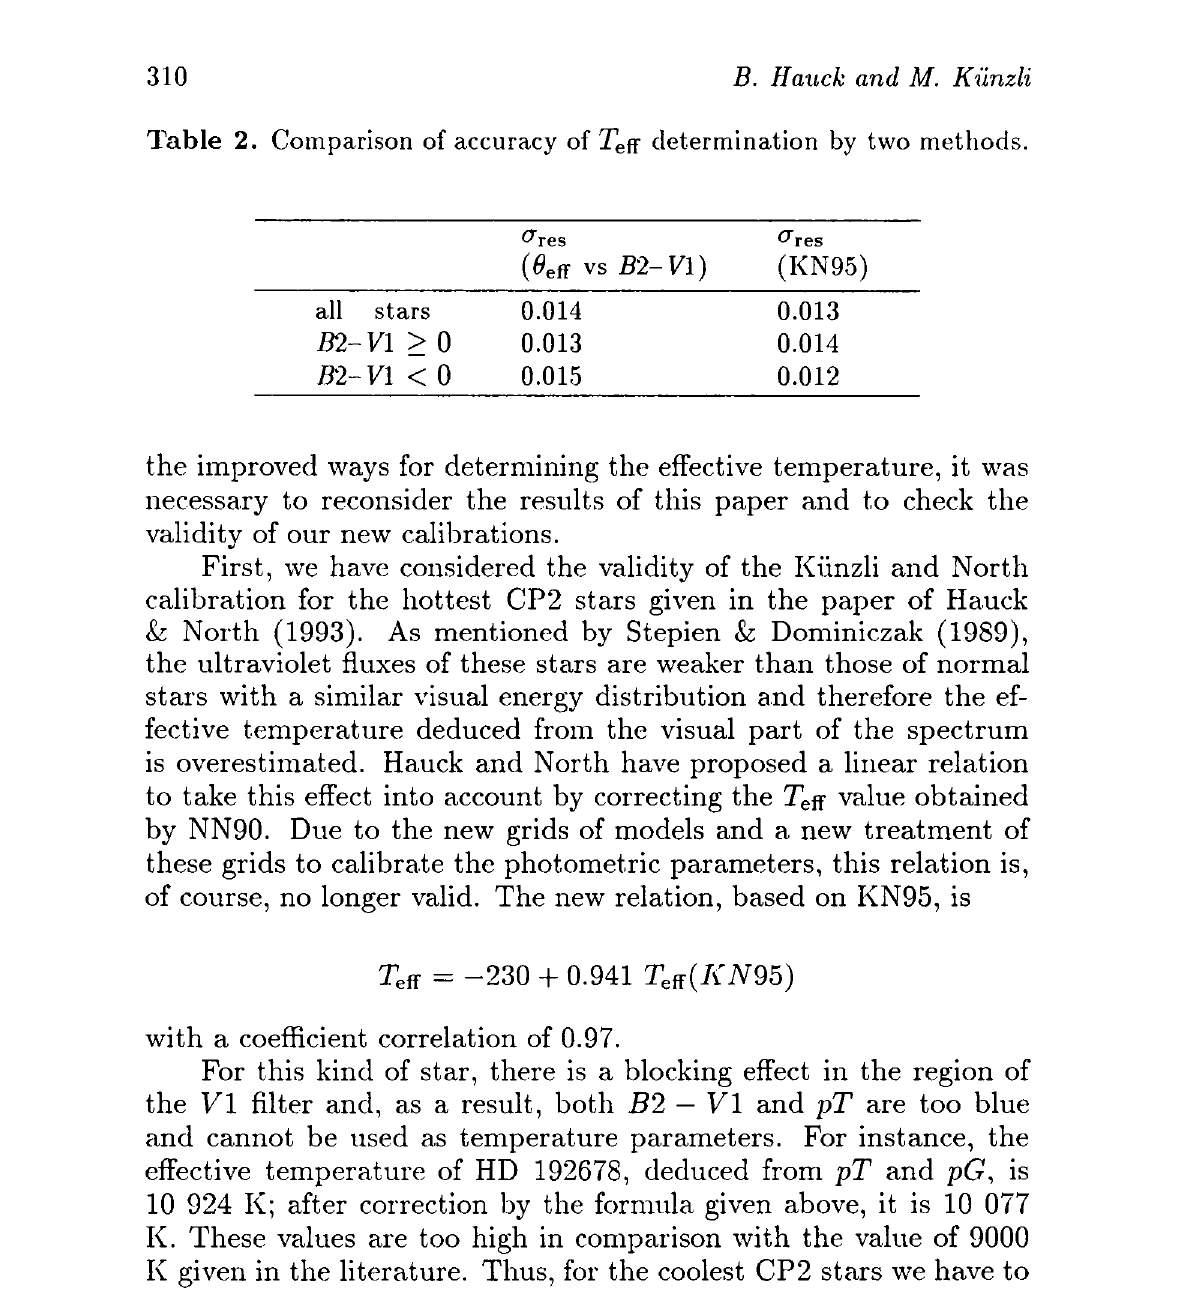
Table 2. Comparison of accuracy of T e ff determination by two